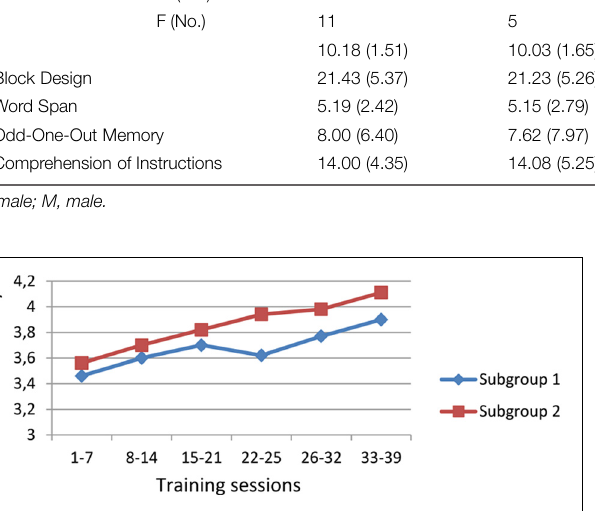
FIGURE 1 | The means of the highest levels in working memory (WM) training for the two subgroups at different stages of the training. Y -axis: level of difficulty refers to the number of figures being detected and remembered. X -axis: training session numbers are grouped in order to contain the same variety of training tasks for each